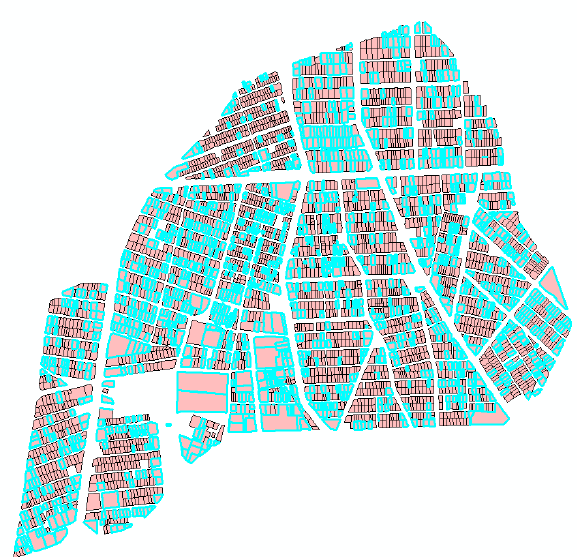
Figure 6. Red polygon: Cadastre Office map (base map), Red polygons with blue border: Suspicious polygons.